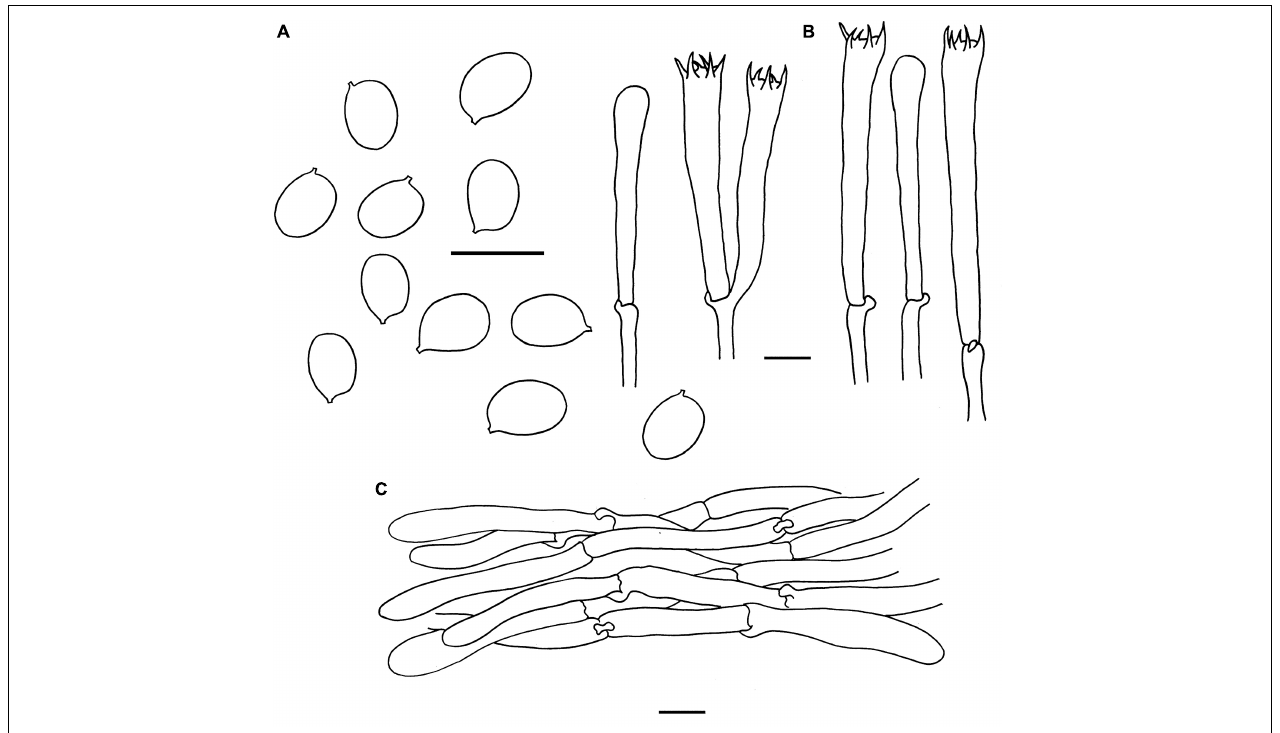
FIGURE 5 | Microscopic features of Cantharellus chuiweifanii (FHMU2412, holotype). (A) Basidiospores. (B) Basidia. (C) Pileipellis. Scale bars = 10 µ m. Drawings by Y. Z. Zhang and D. Y. An.